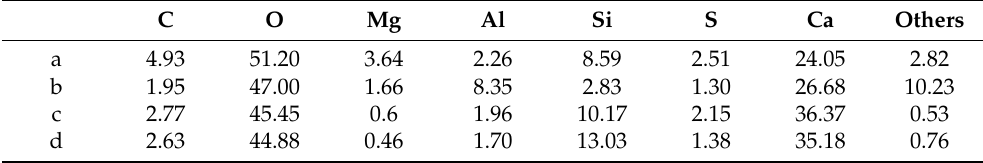
Table 6. The elements in the areas of the sample scanned by EDS.